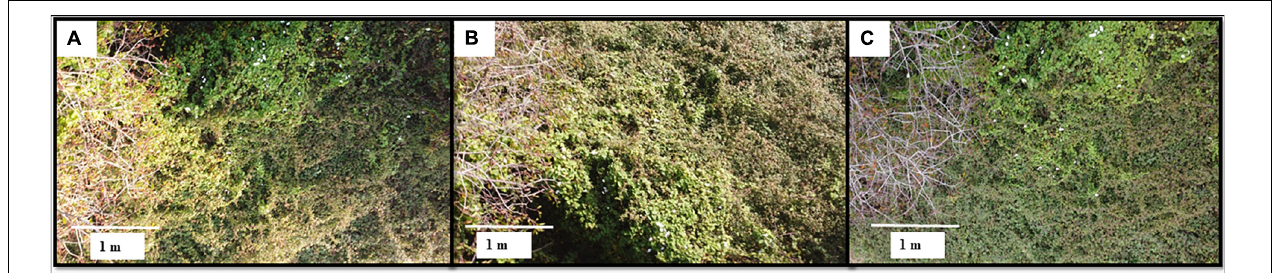
FIGURE 5 | The visibility of flowering bindweed ( Convolvulus ) when imaged under varying natural light intensities at approximately the same location (A) 9:30 (light intensity: 1792 lum/ft 2 ), (B) 12:00 (light intensity: 4096 lum/ft 2 ), and (C) 17:30 (light intensity: 2688 lum/ft 2 ) using an RBG camera (DJI Mavic Mini inbuilt camera) on October 9th, 2021. Light intensity was measured using a HOBO Pendant temperature/light data logger (Onset, Bourne, MA, United States). The ability to discriminate the flowers from the background can be impaired under some viewing and lighting